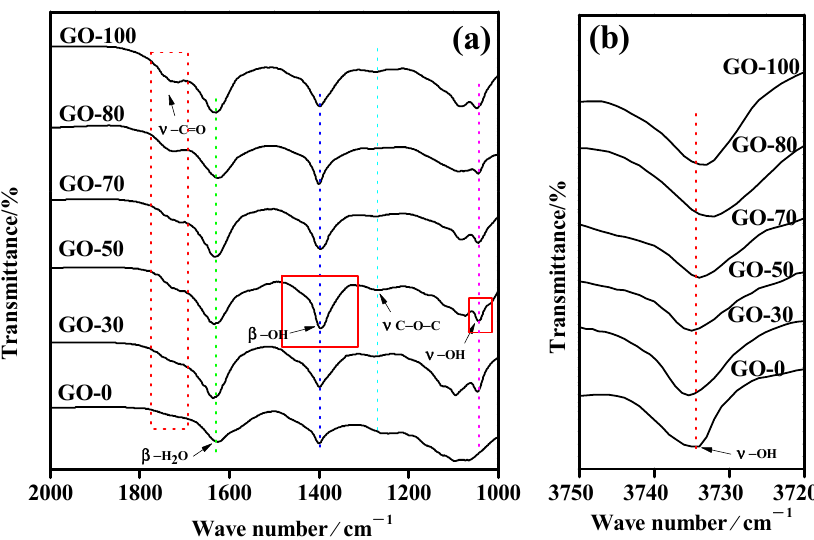
Figure 5. Infrared spectra of graphite oxide samples prepared at different reaction temperatures: ( a ) Infrared spectra between 2000–1000 cm − 1 , ( b ) Infrared spectra between 3750–3720 cm − 1 .